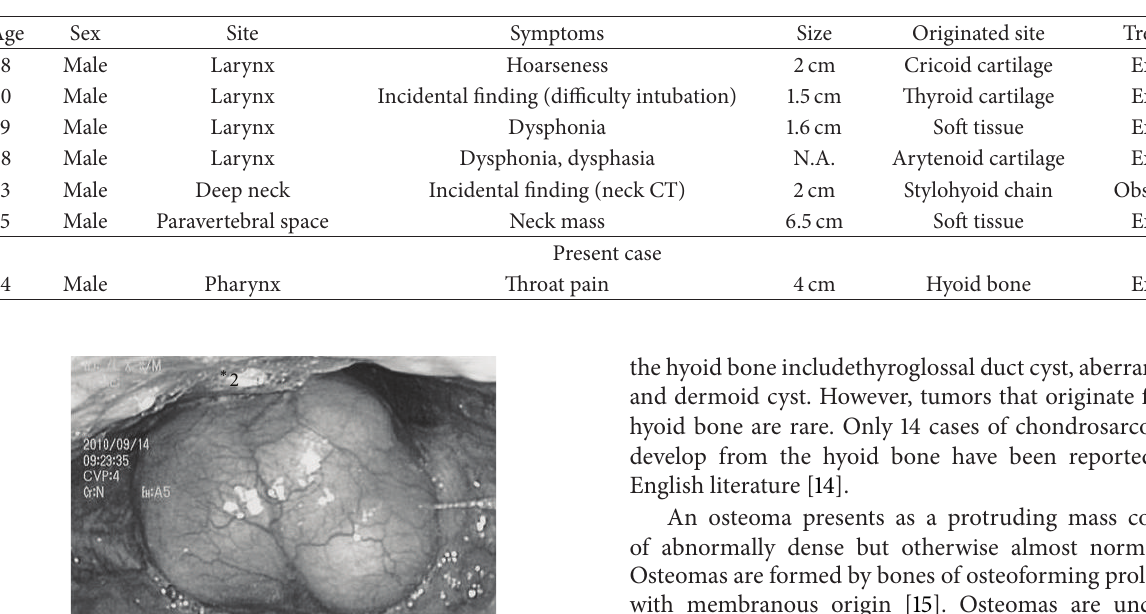
Table 1: Cases of osteomas developed in larynx and neck.